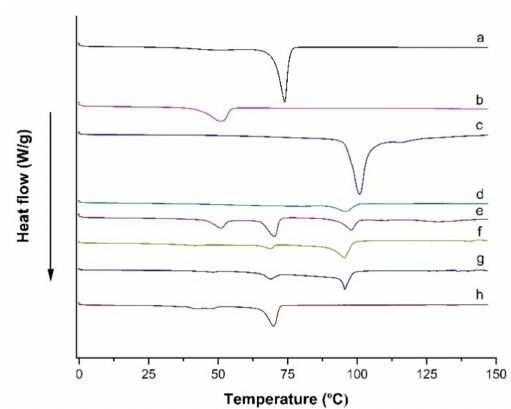
Figure 5. DSC thermograms scanned from 0 to 150 ◦ C at a rate of 10 ◦ C/min for ( a ) Compritol 888 ATO ® , ( b ) Poloxamer 188, ( c ) Trehalose, ( d ) LPV, ( e ) Physical mixture (i.e., Compritol 888 ATO ® , Poloxamer 188, trehalose and LPV), ( f ) Blank formulation, ( g ) LPV-NLC-7-Tres formulation, and ( h ) LPV-NLC-7 formulation.